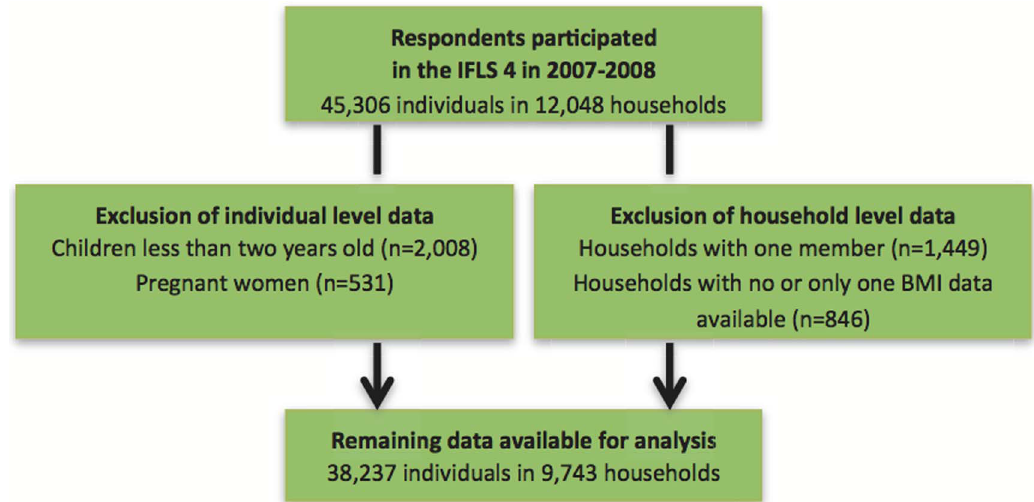
Figure 1. IFLS 4 participants and the exclusion criteria in this study.